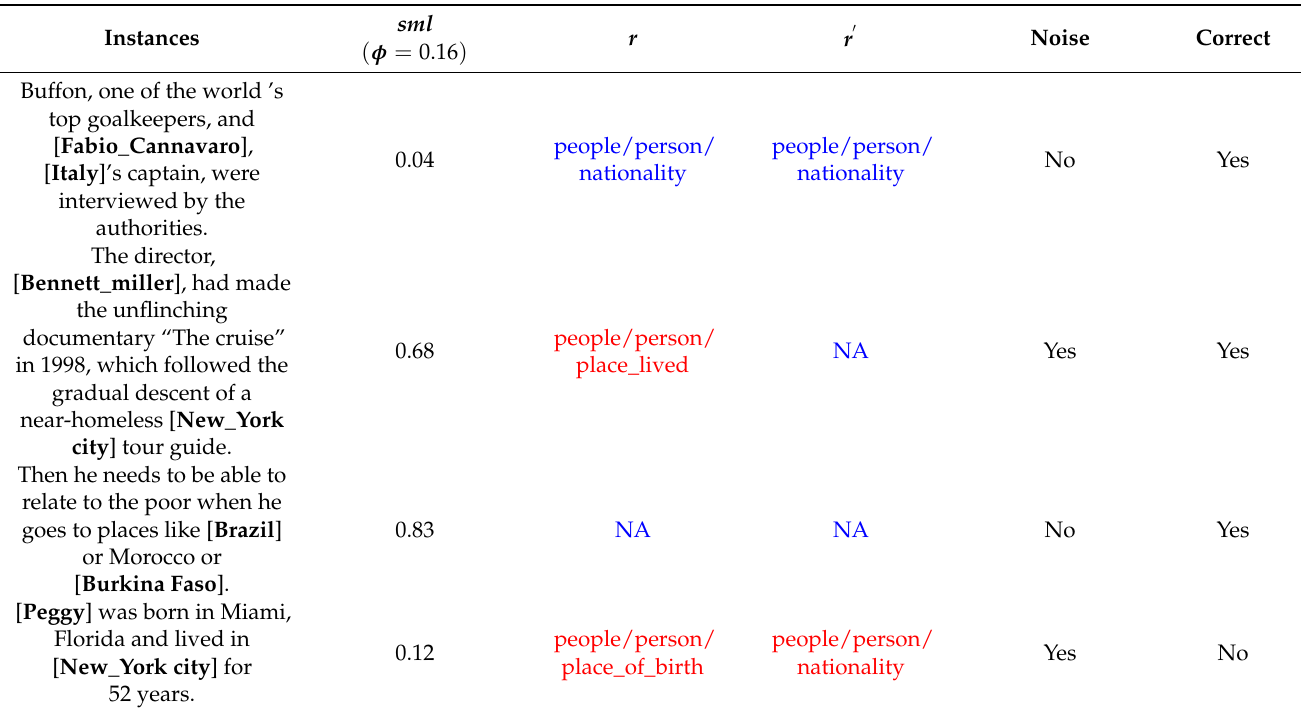
Table 3. Case study: a real example in our dataset for the noise-detection strategy. “Noise” represents whether the instance was detected as a noisy one, and “Correct” represents whether the final label of the instance was